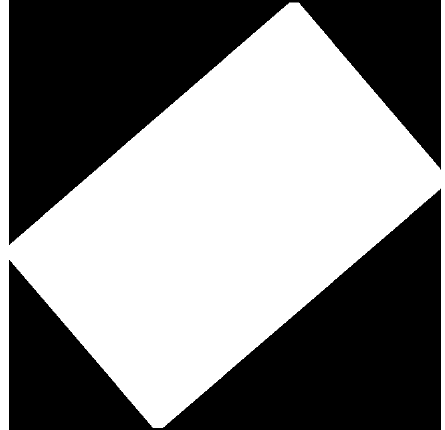
Fig. 1 Orthophoto RGB image of the AOI.